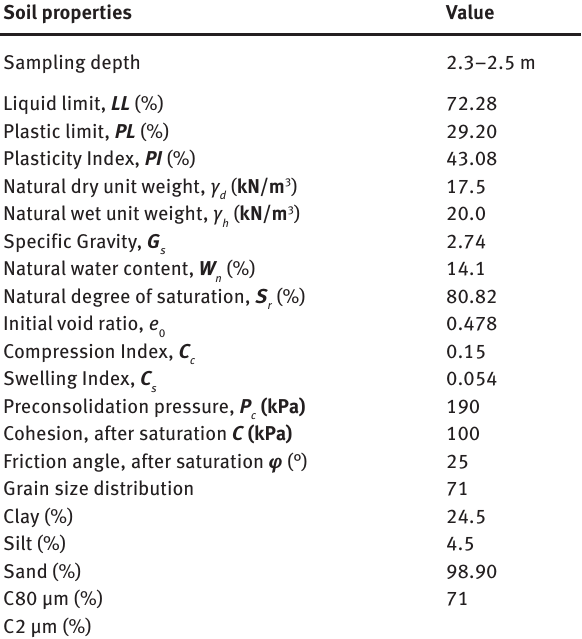
Table 1: Geotechnical characteristics of soil